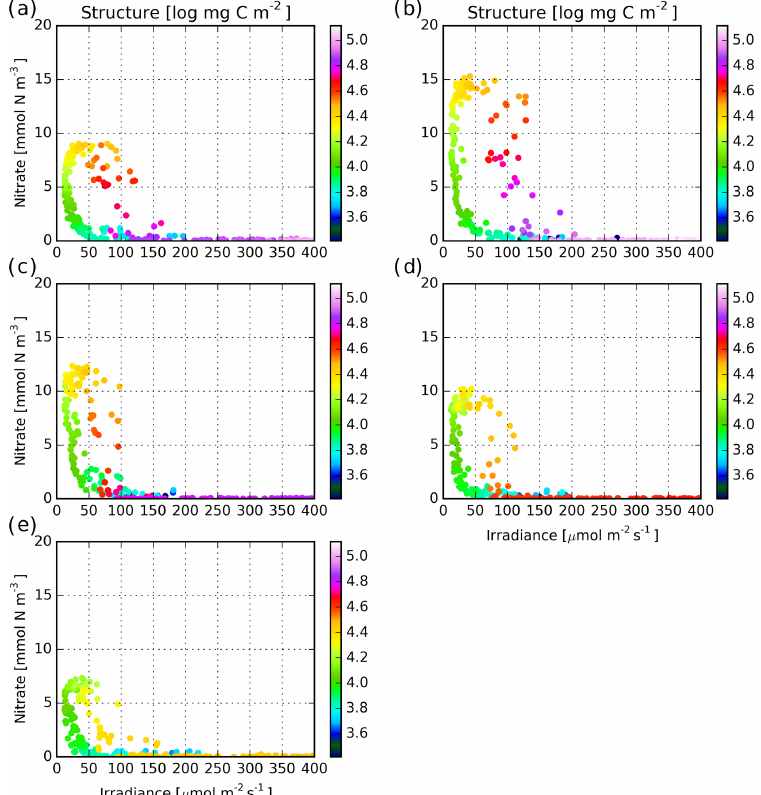
Figure 15. Logarithm of structural biomass as a function of irradiance and nitrate concentrations in the model for the Sound of Kerrera farm: (a) 2006, (b) 2007, (c) 2008, (d) 2009 and (e)